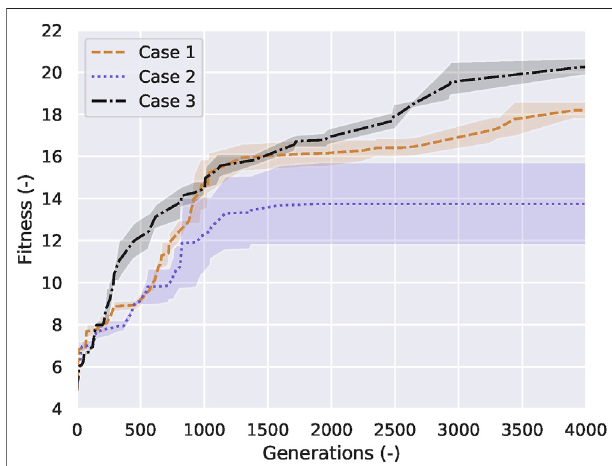
FIGURE 9 | Results for all three cases within 4,000 generations. The median values of the brown dashed, purple dotted, and black dashdotted lines stand for free scaffolded learning case (Case 1), time-constrained scaffolded learning case (Case 2) and performance-based scaffolded learning case (Case 3), respectively. The shaded regions represent the standard deviation of each case. The variance of Case 2 and Case 3 are greaterthanCase1becausewerestricttherangeofthebodylengthofCase2 and3basedonthetimeandthecurrent fi tness,whileweletthebodylengthof Case 1 evolve